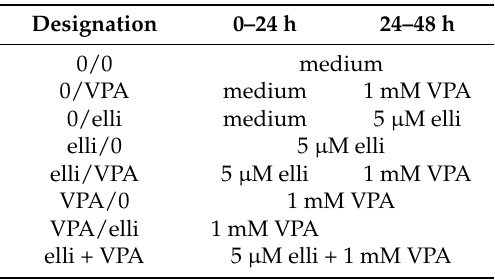
Table 1. Treatment schedules of ellipticine (elli) and valproic acid (VPA) used in UKF-NB-4 and SH-SY5Y neuroblastoma cell